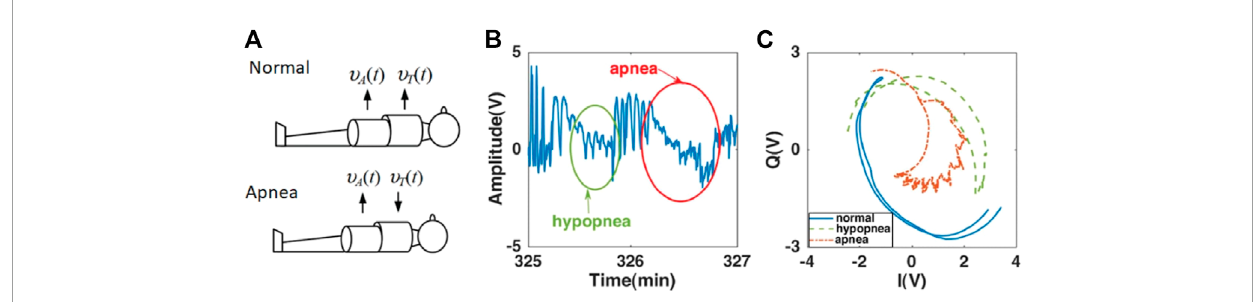
FIGURE 7 Doppler radar measurements used to recognize occurrence of obstructive sleep apnea (OSA) events. Whereas in Normal Breathing, the direction of displacement of chest and abdomen are in the same direction, the displacements are in opposite directions during Apnea Breathing (A) During an apnea (full respiratory obstruction) or hypopnea (partial obstruction) event, variations in chest and abdomen displacement occur which are evident in the radar time domain displacement plot (B) . The temporal-spatial variations caused by paradoxical breathing during apnea vents are discernible through an increase in hysteresis for the arcs traced in the I-Q plot during the respiratory cycle (C) (Baboli et al., 2020).